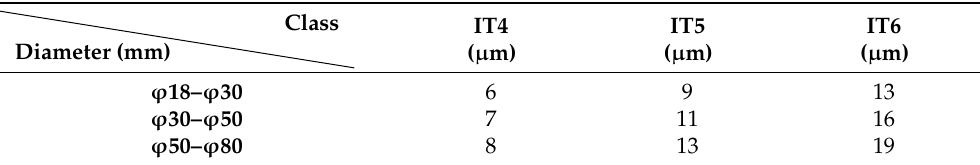
Table 8. Tolerance zone.